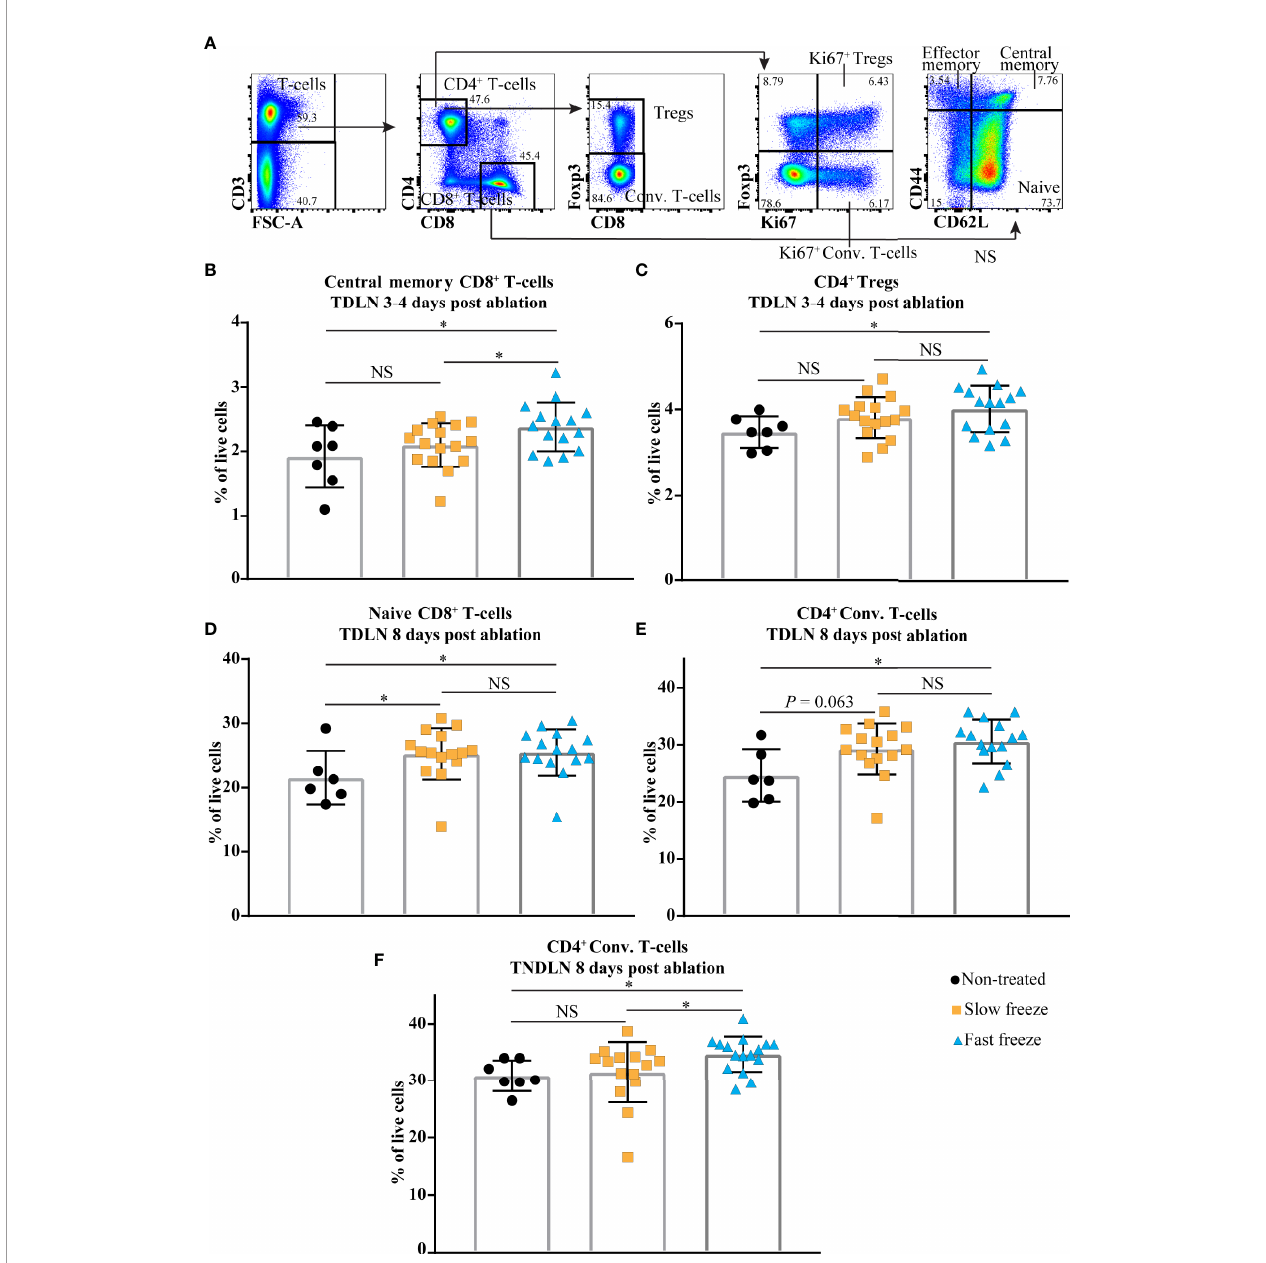
FIGURE 3 | Cryoablation-induced changes in the immune cell compartments in local tumor draining lymph node (TDLN) and distant contralateral tumor non-draining lymph node (TNDLN). (A) Flow cytometry gating strategies employed to characterize CD4 + and CD8 + T-cell subsets. (B, C) Percentages of CD8 + central memory T- cells and CD4 + regulatory T-cells (Tregs) within live cells in TDLN at day 3-4 post cryoablation. (D, E) Percentages of CD8 + naive T-cells and CD4 + conventional (Conv.) T-cells within live cells in TDLN at day 8 post cryoablation. (F) Percentages of CD4 + Conv. T-cells within live cells in TNDLN at day 8 post cryoablation. Data plotted as mean and ± S.D. obtained from four independent experiments (n = 6-16). Each data point represents an individual mouse. Data was analyzed using non- parametric Mann-Whitney U test. * P < 0.05, NS, not signi fi